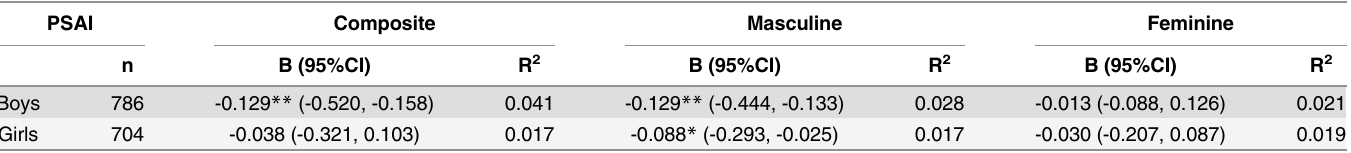
Covariates:birth weight, maternal smoking during pregnancy, maternal alcohol consumption during pregnancy, brothers,